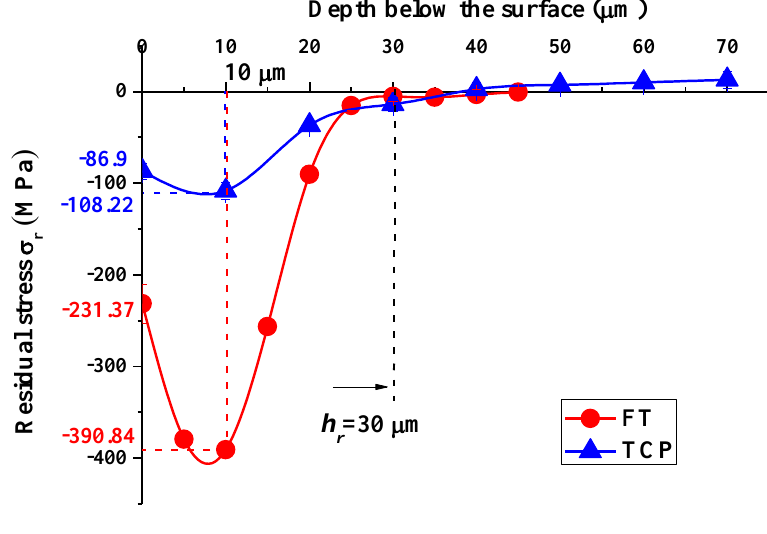
Figure 5. Residual stresses distributions.